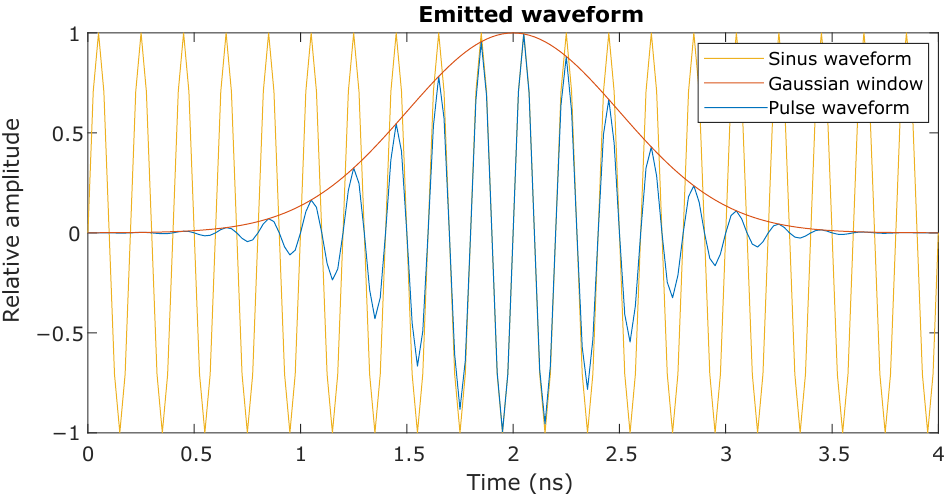
Figure 3. The emitted signal used for simulation the radar sensor. The sinusoid carrier (yellow) is modulated with a Gaussian window filter (orange) to produce a pulse signal